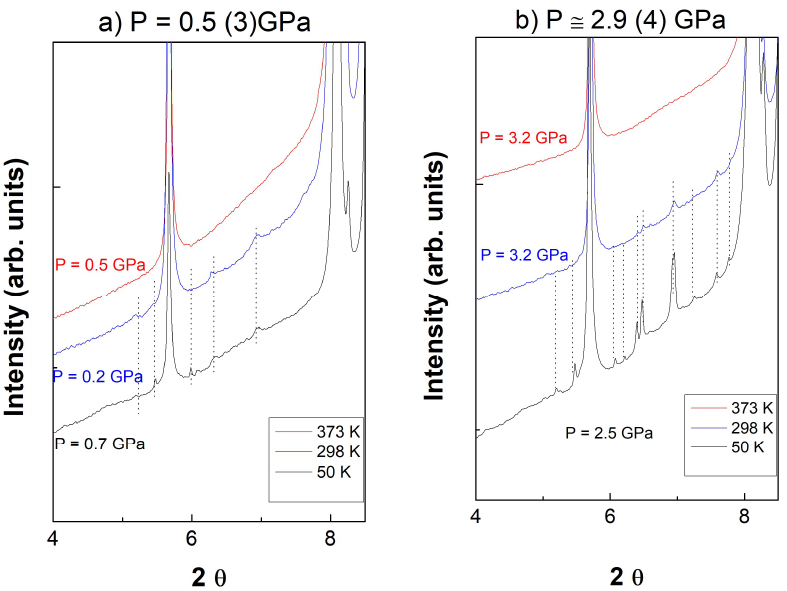
Figure 4. Temperature dependence of the superlattice reflections at ( a ) 0.5 (3) GPa and ( b ) 2.9 (4) GPa.